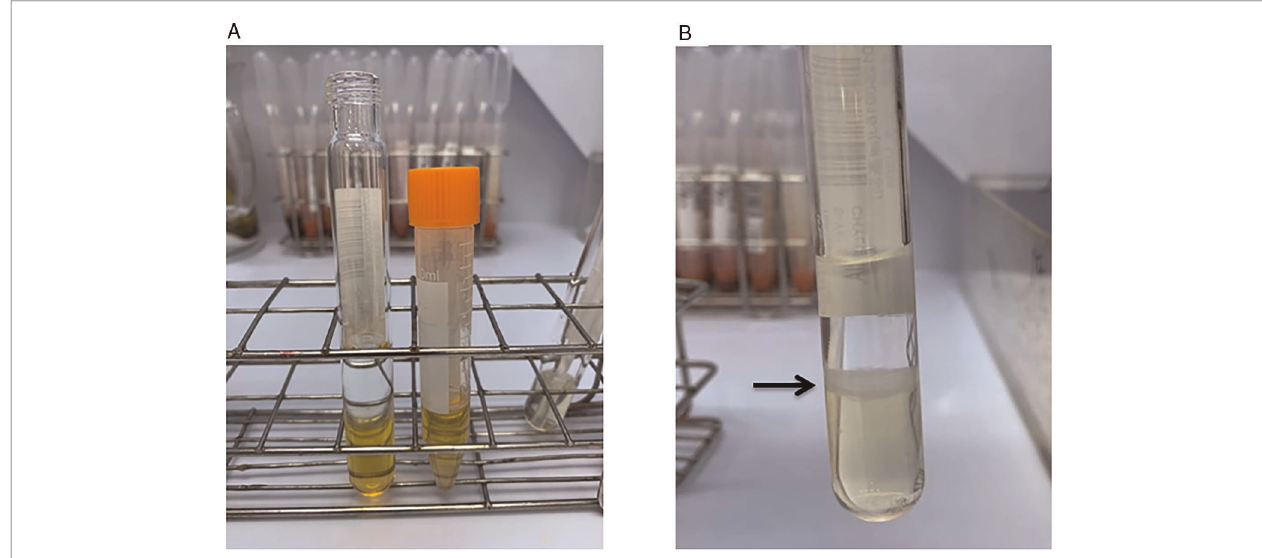
FIGURE 1 | ( A ) A urine sample before the experiment and ( B ) after mixing with 5mL diethyl ether (E Merck, D-6100 Darmstadt, F.R. Germany) and centrifugation at 1,500rpm for 2min. The black arrow indicates the opaque layer we extracted for determination of